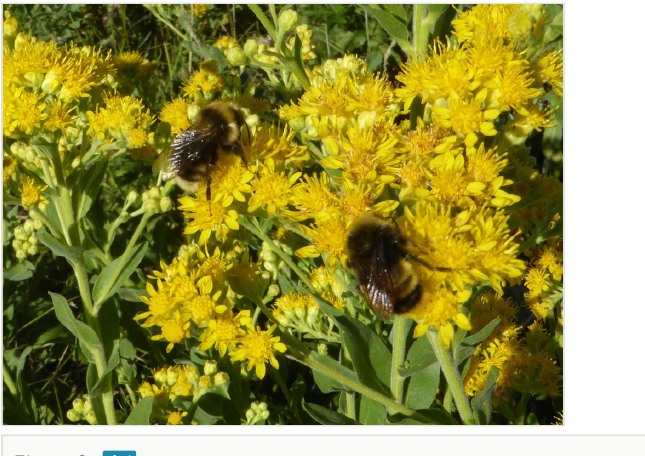
Figure 3. Male Bombus occidentalis Greene (background) and B. terricola Kirby (foreground) in Regina, Saskatchewan, possibly the most eastern location in Canada where both species at risk co- occur naturally. Photo by Cory S. She ffi eld.